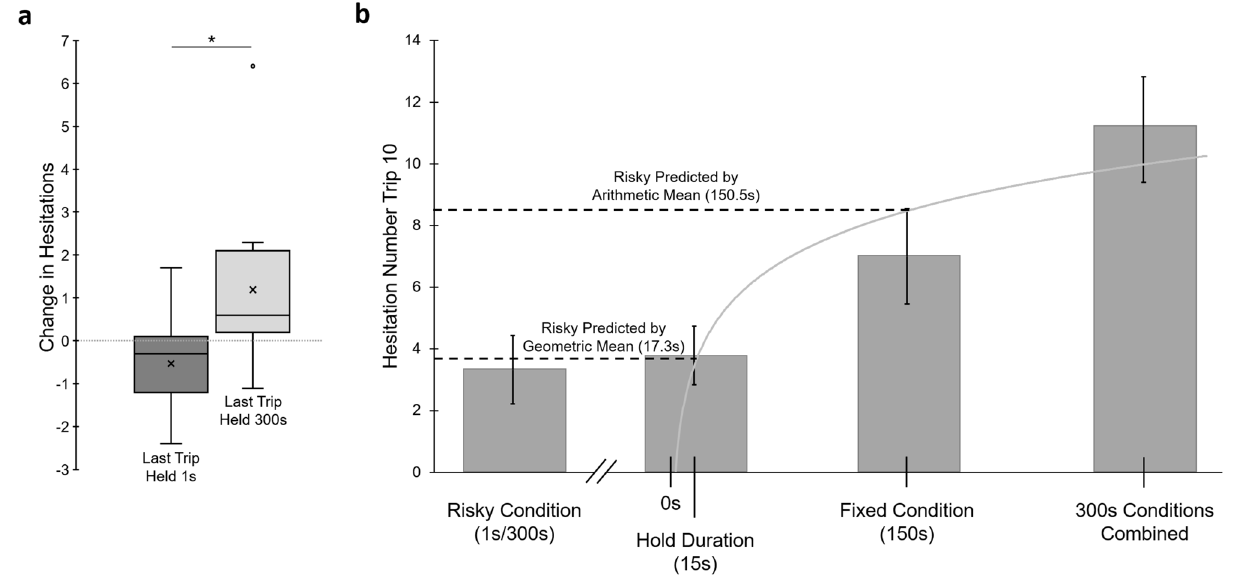
Figure 8. Hesitation changes by last experienced outcome in the Risky condition and between condition comparisons on training Trip 10. ( a ) Mean Change in hesitation numbers in the Risky condition across training based on the outcome of the previous trip (Held 300 s or 1 s). Mean change across training was calculated per individual. Box plots shows the median hesitation change (middle line), mean hesitation change (×) and 25th and 75th percentile (box) while the whiskers extend to min and max values (excluding outliers). Outliers were defined as values 150% of the IQR beyond 25th and 75th percentile and represented as individual points. *Denotes a significant difference between conditions (p < 0.05). ( b ) Predicted hesitations at training Trip 10 along a logarithmic curve (grey line) calibrated by hesitation numbers in the Hold Duration (15 s), Fixed condition (150 s), and the combined 300 s conditions (mean hesitations ± S.E. ). The Risky condition’s mean number of hesitations on Trip 10 is plotted on the left, with the predicted value of either the